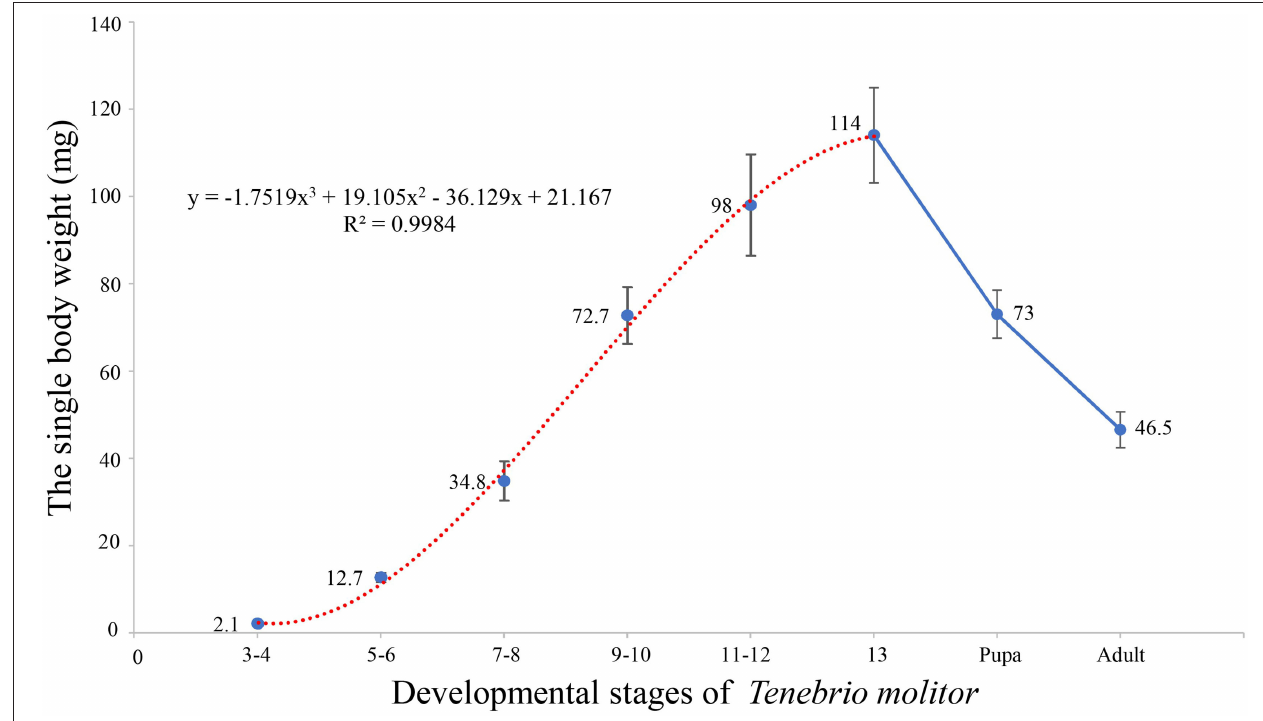
FIGURE 1 | The dynamic of weight of single Tenebrio molitor in different